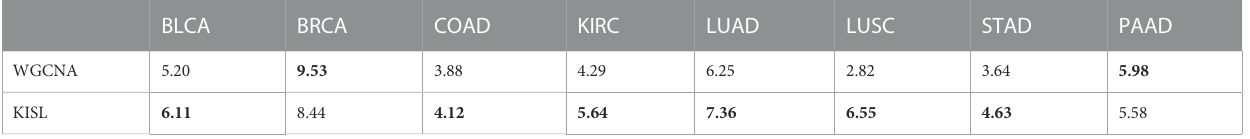
The bold words in Table 1 indicate the maximum value of the column, and the KISL algorithm obtains the maximum value on most data sets.